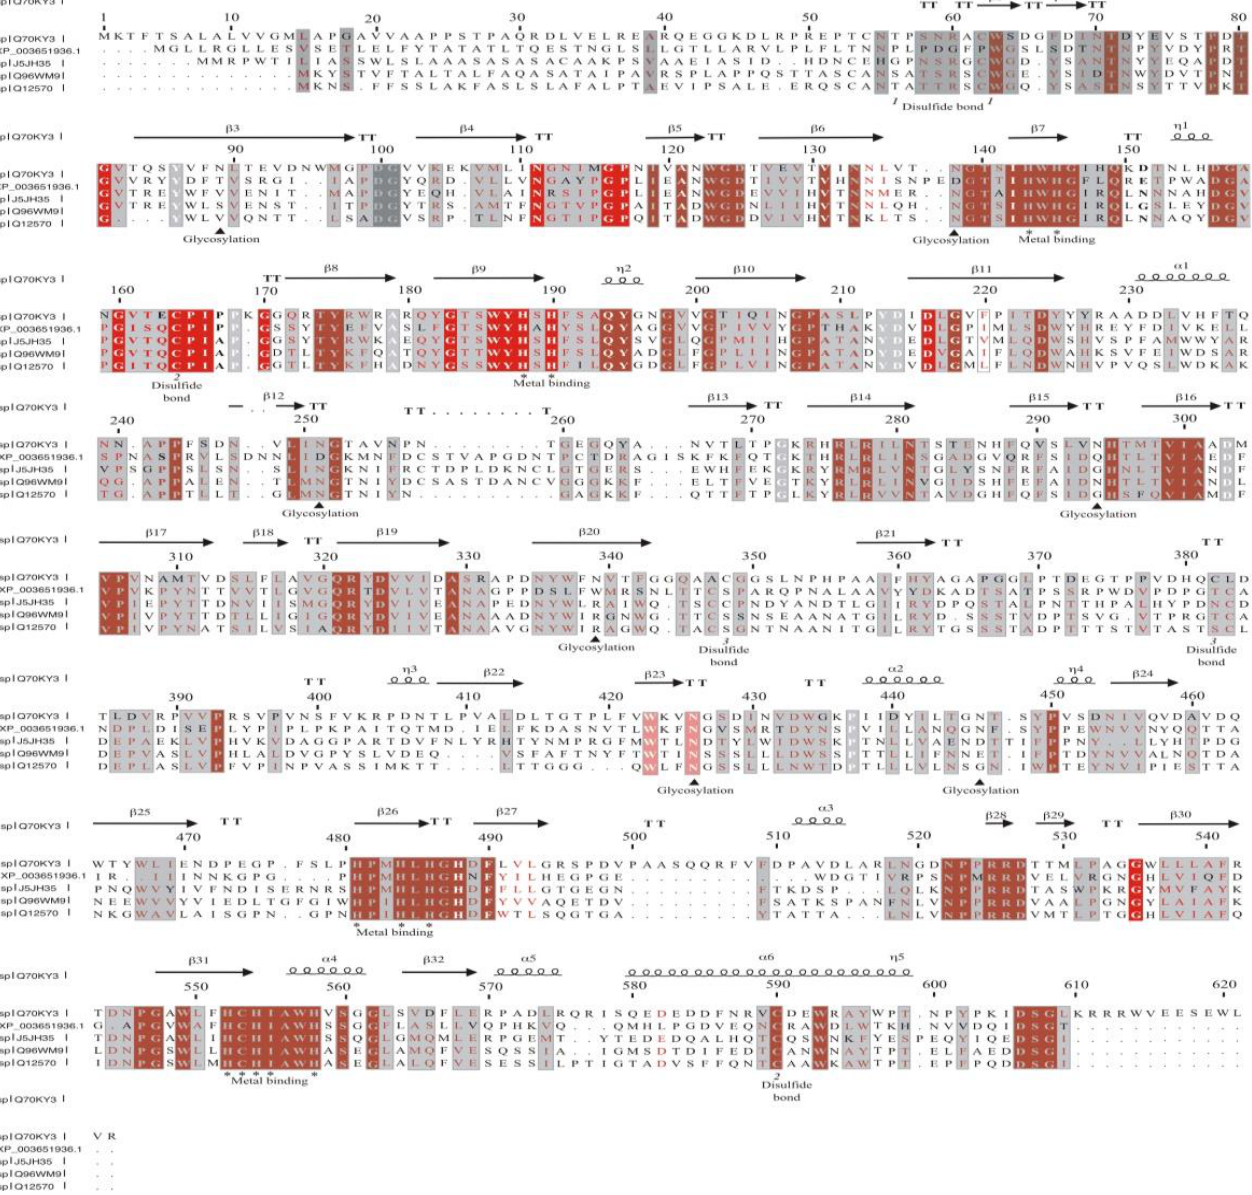
Figure 12. Multiple sequence alignment and secondary structure element assignment. The alignment included oxidoreductase from Beauveria bassiana ARSEF 2860, laccases from Botrytis cinerea (UniProtKB: Q12570, LAC1_BOTFU; UniProtKB: Q96WM9, LAC2_BOTFU), the multicopper protein from T. terrestris NRRL 8126 (THITHE NRRL 8126; UniProtKB: G2R0D5), and 3D crystal structure laccase from M. albomyces MaLac1 (UniProtKB: Q70KY3, PDB code 3QPK). The metal- binding sites were manually determined. The helices are marked as alpha or beta based on the